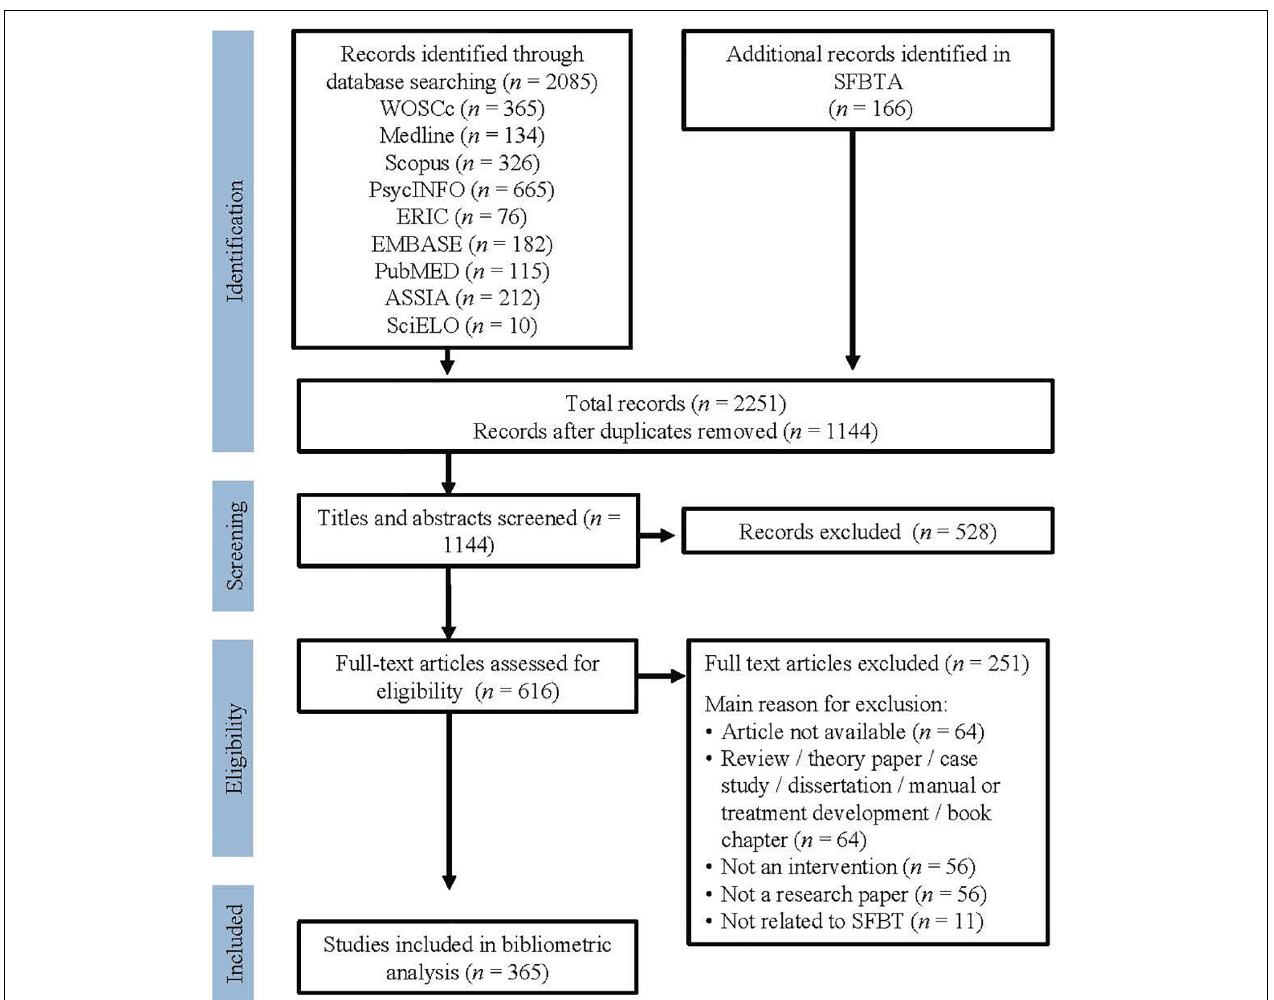
FIGURE 1 | Flow chat through the different phases of the literature